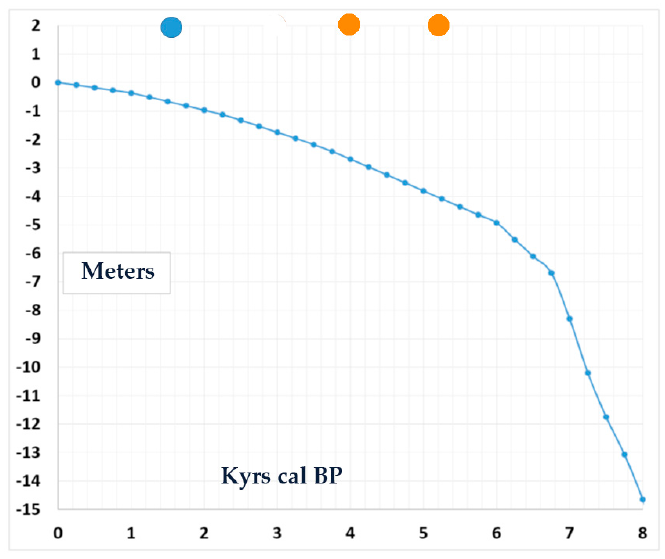
Figure 6. Sea level rise curve since 8 kyr cal BP for Palinuro. Orange squares: U-Th ages of the continental portion of the stalagmite. Blue dot: 14 C age of the barnacle overgrowth. Also see Figure 2. Table 5. Results of the 14 C and U-Th dating of the vadose speleothem (Palinuro-2 and Palinuro-3) and marine overgrowth (Palinuro-1) from Palinuro. 238 U and 232 Th concentrations were determined using the enriched 236 U and 229 Th isotopes, respectively. δ 234 U m = {[( 234 U/ 238 U) sample /( 234 U/ 238 U) eq ] − 1} × 1000, where ( 234 U/ 238 U) sample is the measured atomic ratio and ( 234 U/ 238 U) eq is the atomic ratio at secular equilibrium. δ 234 U (0) corr is the initial value and is calculated by the equation δ 234 U (0) = δ 234 U m exp( λ 234 t), where t is the corrected age in years and λ 234 is the decay constant for 234 U. * Ages corrected for detrital 230 Th using an initial 230 Th/ 232 Th activity ratio of 0.85 ± 0.36 [74]. AMS- 14 Sample Code